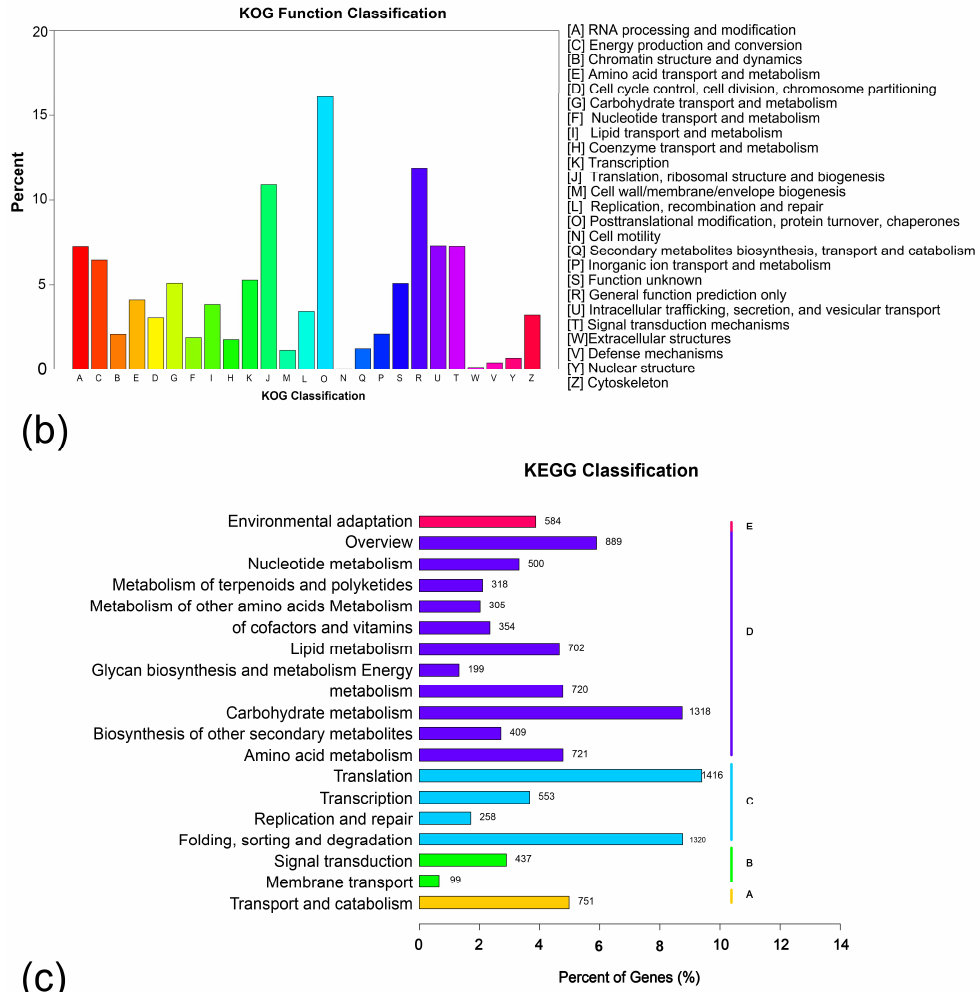
Figure 2. The annotation of identified unigenes in three databases. ( a ) GO function classification, 4 where the horizontal axis shows the three GO terms: biological processes, cellular components, and molecular functions; the vertical axis shows the number of genes annotated under each term. ( b ) KOG function classification, where the vertical axis gives the names of the 26 KOG groups, and the horizontal axis gives the percentages of annotated genes. ( c ) KEGG pathway annotation, where the vertical axis gives the names of the KEGG metabolic pathways, and the horizontal axis gives the numbers and percentages of genes annotated to this